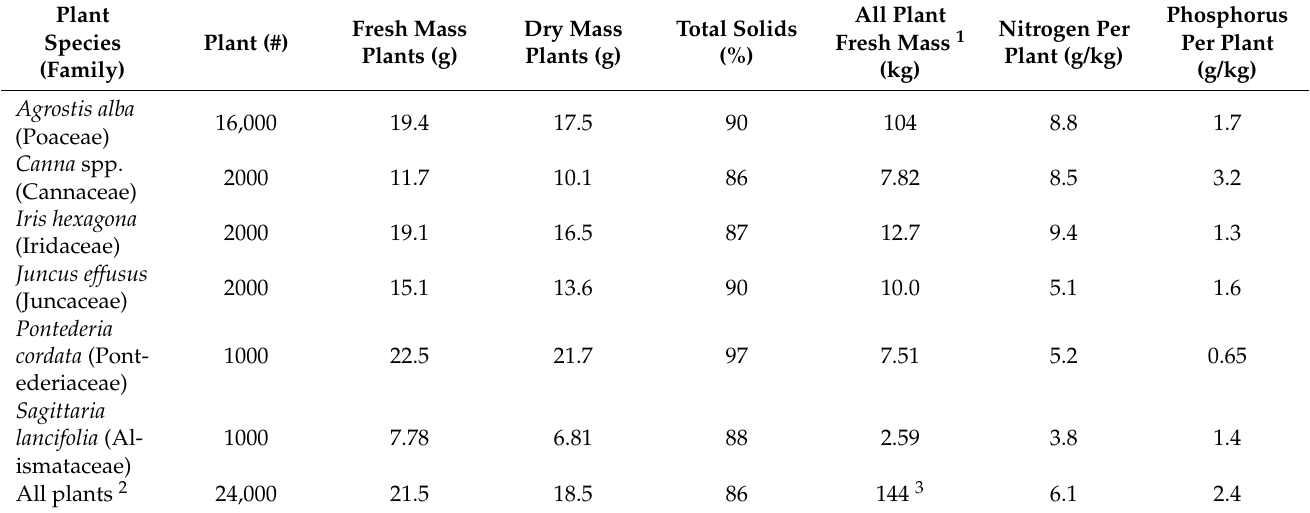
Table 1. Initial plant biomass ( n = 3, per species) and nutrient composition (based on fresh mass) of plants installed in April 2018 in floating treatment wetlands deployed within the Wickham Park pond in Melbourne, FL, USA.